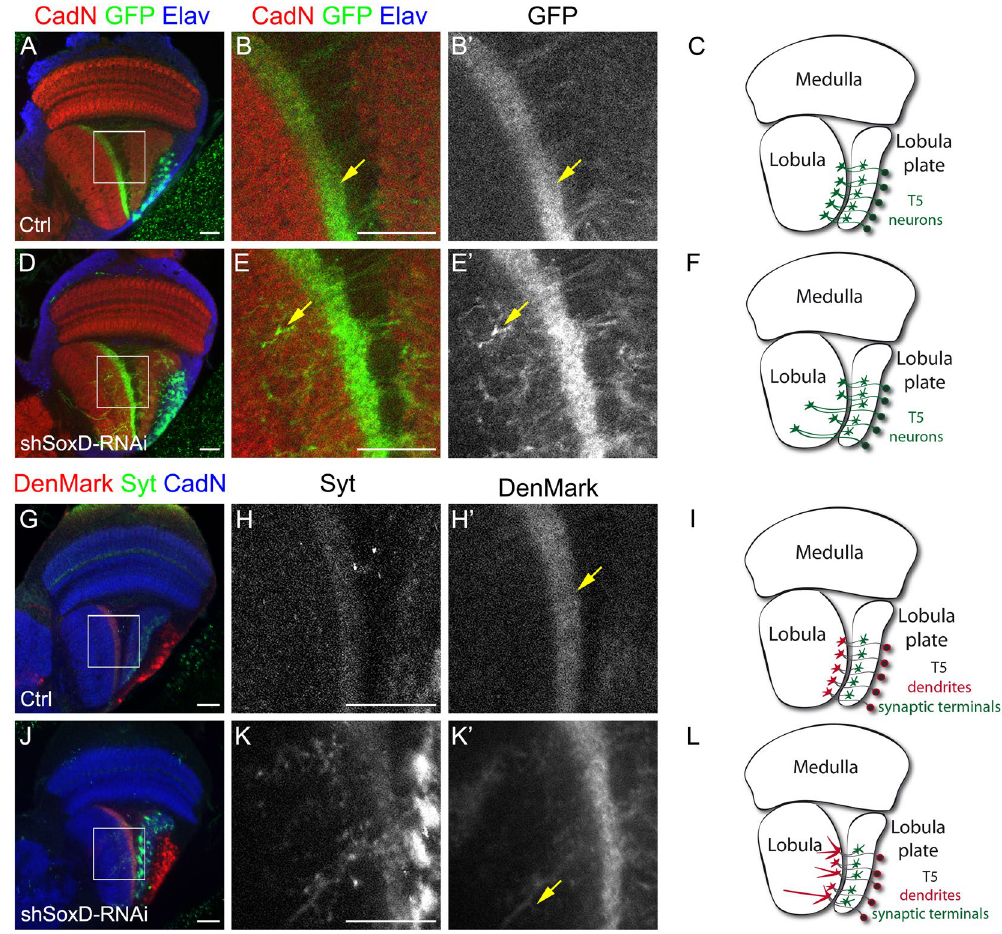
Figure 6. SoxD controls T5 arborisation in a neuronal-autonomous manner. ( A,B’ , D,E ’) Immunofluorescence of adult optic lobes of R42H07-GAL4, UAS-mCD8-GFP ( A,B ’) control and ( D,E ’) shSoxD-RNAi knockdown, against GFP (green), Elav (blue) and CadN (red). ( C , F ) Schemes showing lobula plate T5 neurons in ( C ) control and ( F ) SoxD knockdown backgrounds. ( G,H ’, J,K ’) Immunostaining of adult optic lobes of R42H07-GAL4, UAS-DenMark, UAS-syt-eGFP ( G,H’ ) control and ( J,K’ ) shSoxD-RNAi knockdown, against GFP (green), RFP (red) and CadN (blue). (I,L) Schemes showing lobula plate T5 neurons in ( I ) control and ( L ) SoxD knockdown backgrounds. Arrows point to ( B , B’ , E , E’ ) neurites or ( H,H’, K,K’ ) dendrites in location. Scale bars are 20 µ